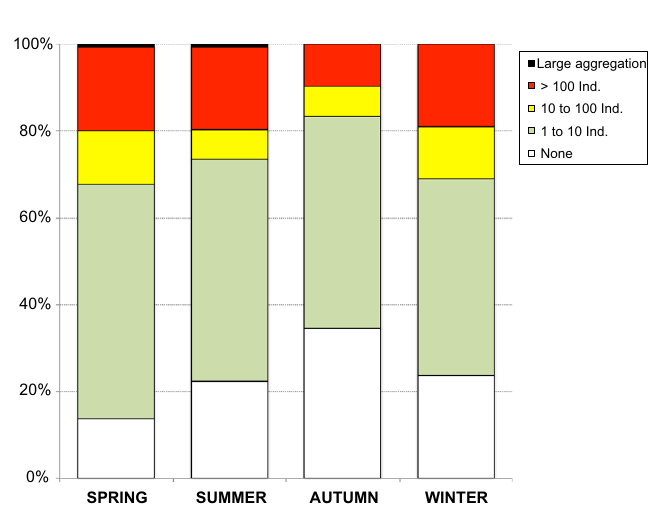
Figure 7. Visual observations of Pelagia noctiluca presence in the study area (March 2015–January 2016): Seasonal distribution of relative percentages of events in the five classes of